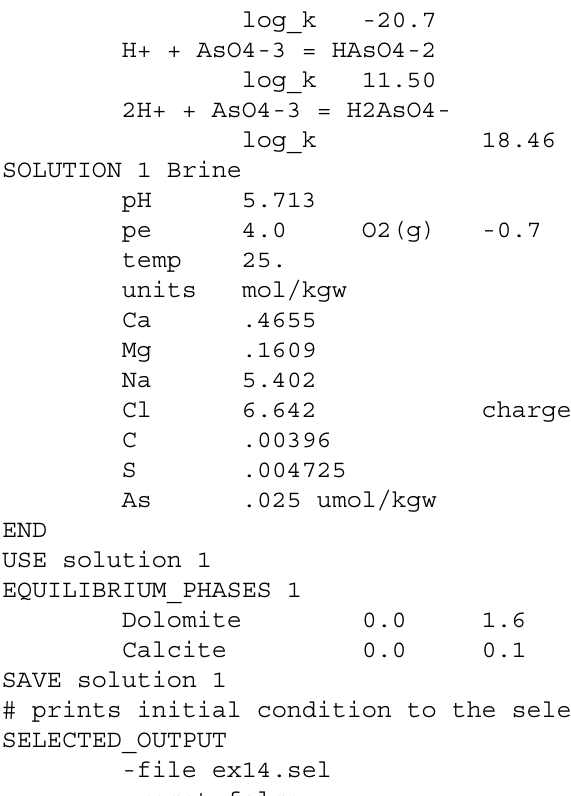
Table 37. Input file for example